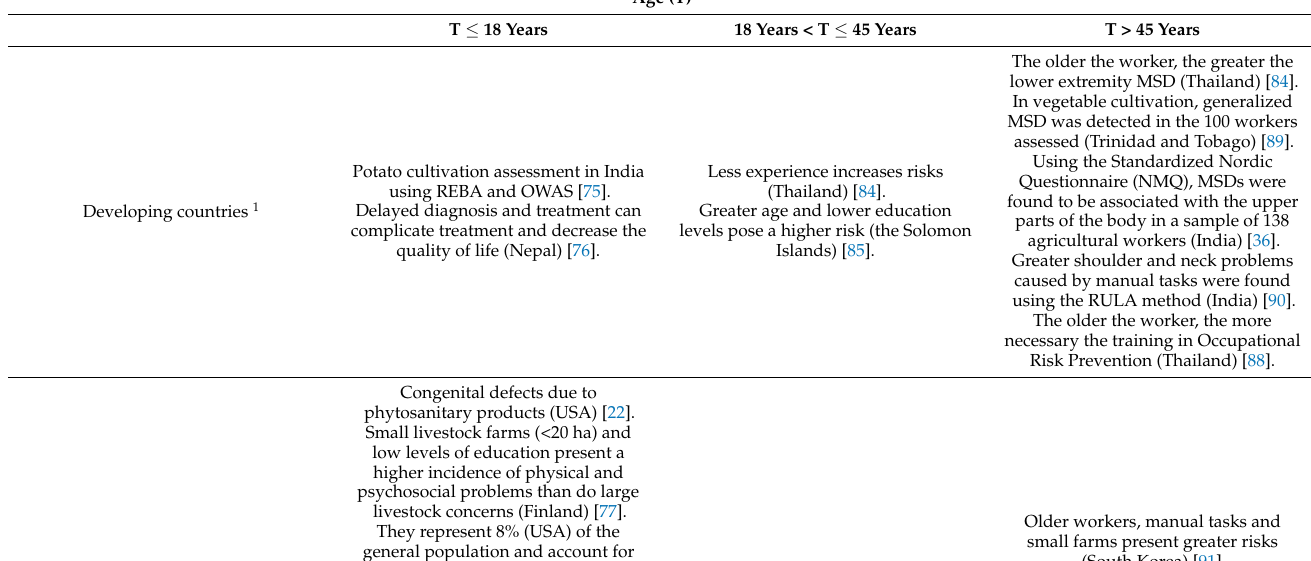
Table A1. MSD research in agriculture (1995–2020). Category: Age. Age (T) T ≤ 18 Years 18 Years < T ≤ 45 Years T > 45 Years